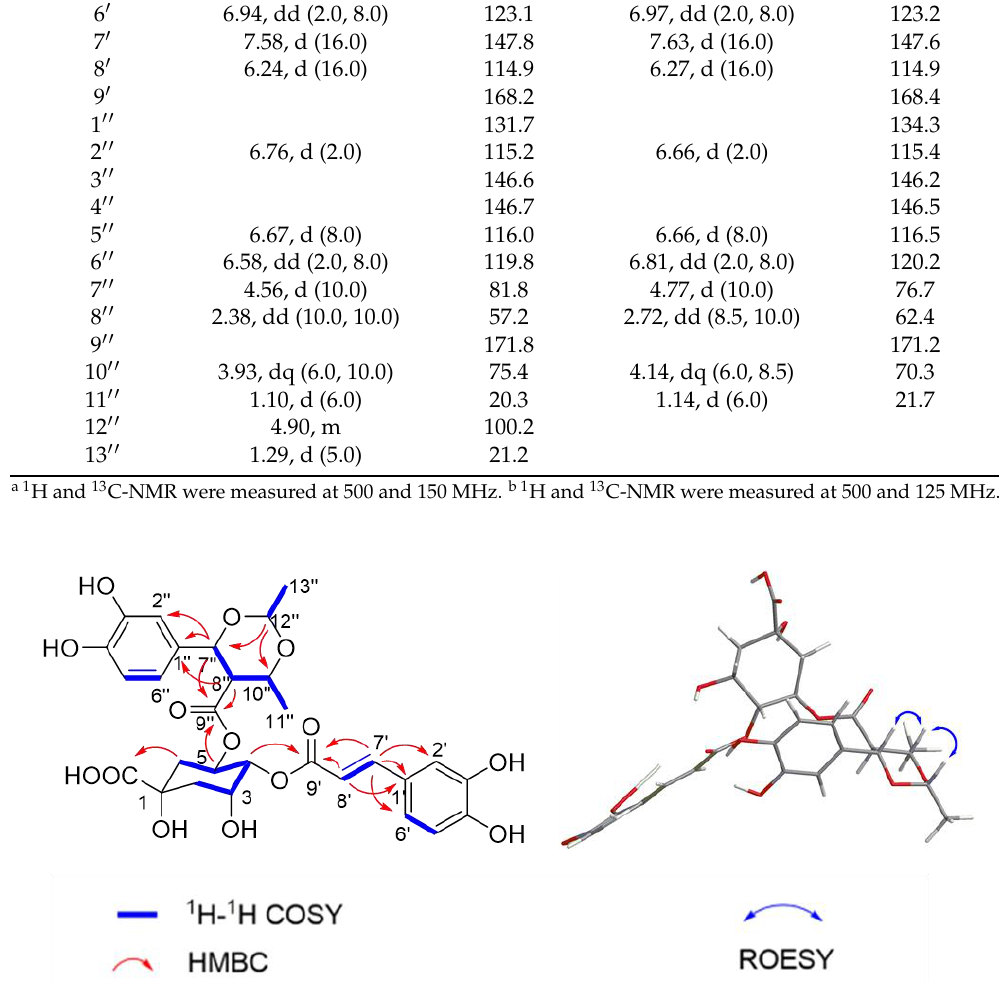
Table 1. NMR spectroscopic data for compounds 1 , 2 in methanol- d 4 ( δ in ppm, J in Hz).